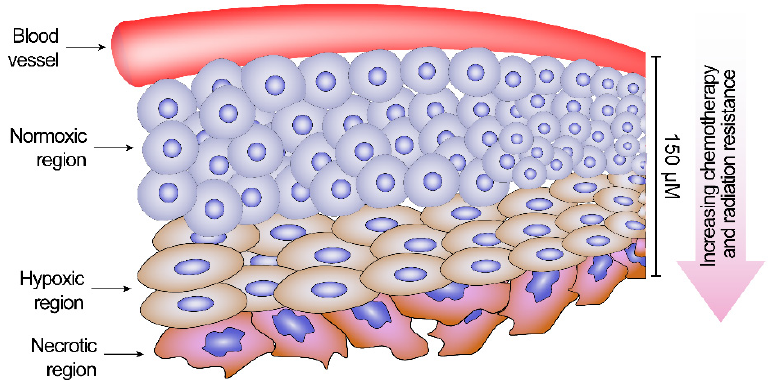
Figure 2. A graphical illustration of varied regions in solid tumors. The tumor region close to the blood vessel contains oxygenated cells, followed by a region of hypoxic cells and necrotic cells. Adapted from [72,73].